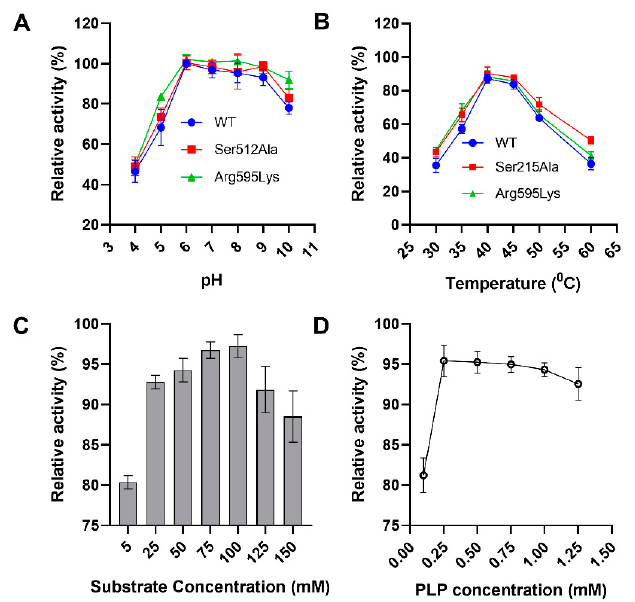
Figure 3. Biochemical characterization of the pure SmcadA. ( A ). A graph showing the optimal pH of SmcadA. The reaction mixtures were incubated at different pHs ranging from 4–10 at 37 °C. ( B ). This shows the optimum temperature after incubating samples at temperature values ranging from 30–60 °C. ( C ) L-lysine substrate concentrations and ( D ). PLP concentrations. The reaction mixture composed of 500 mM acetate buffer at the optimal pH 6.